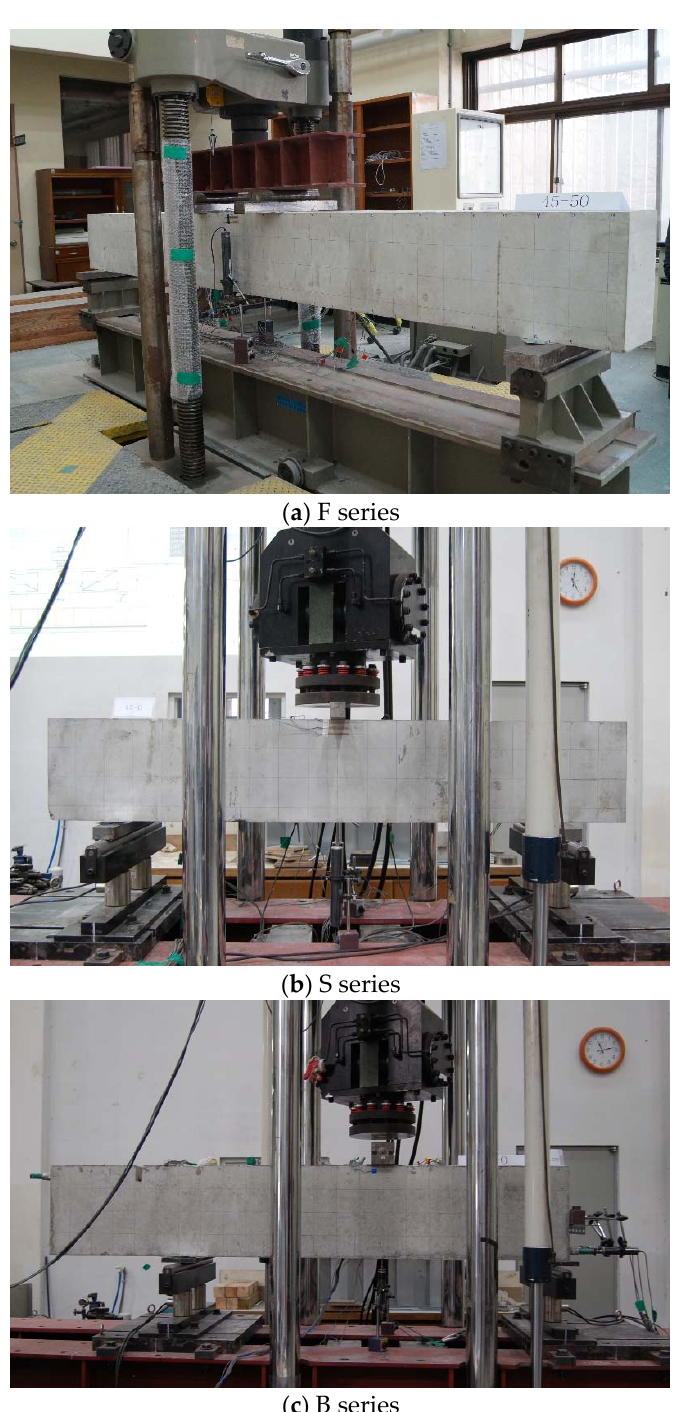
Figure 4. Test setup of specimen. The deflection of the beam by loading was measured by installing a linear variable differential transducer (LVDT) (Tokyo Measuring Instruments Lab., Tokyo, Japan) at the central bottom of the loading point where the maximum deformation of the specimens was generated. In addition, strain gauges for concrete were attached to positions 10 mm and 30 mm away from the compressive edge to measure the strain of the concrete at the